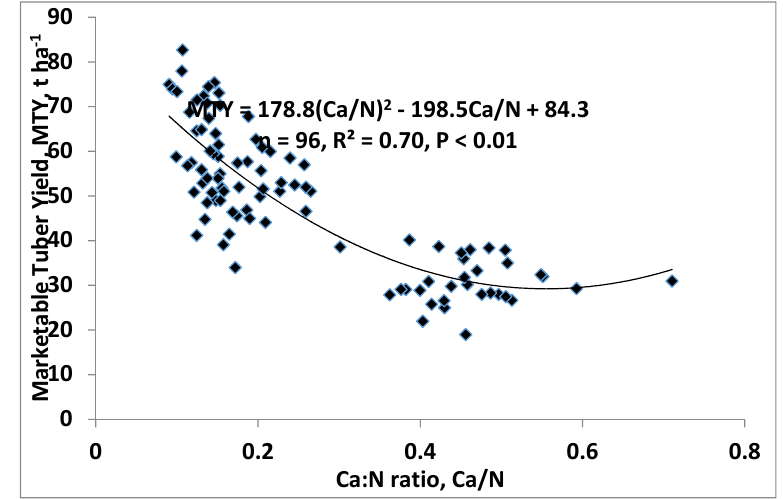
Figure 5. The MTY as a function of Ca:N ratio in potato stems.